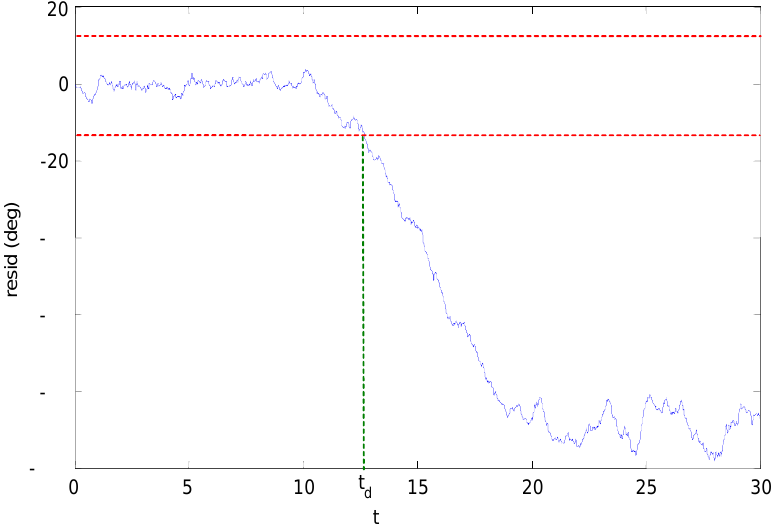
Figure 5. Angle sensor failure: CUSUM filtered residual of GVIRT and